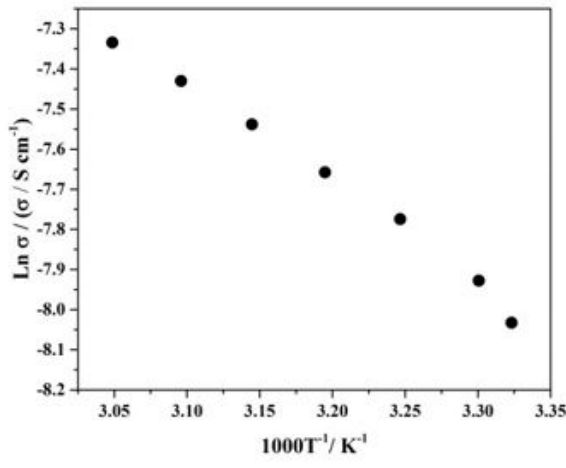
Figure 1: Variation of conductivity of the gel polymer electrolyte (GPE) with inverse